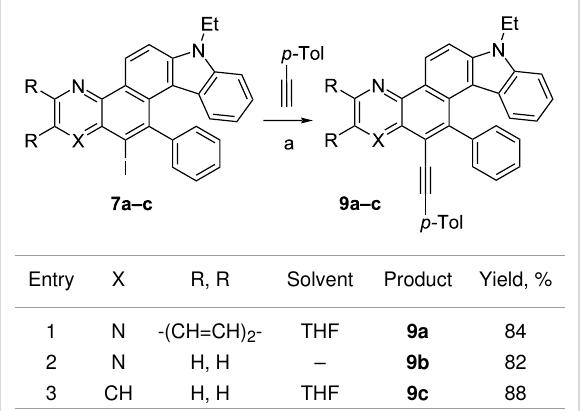
Table 4: Sonogashira coupling of compounds 7 with p